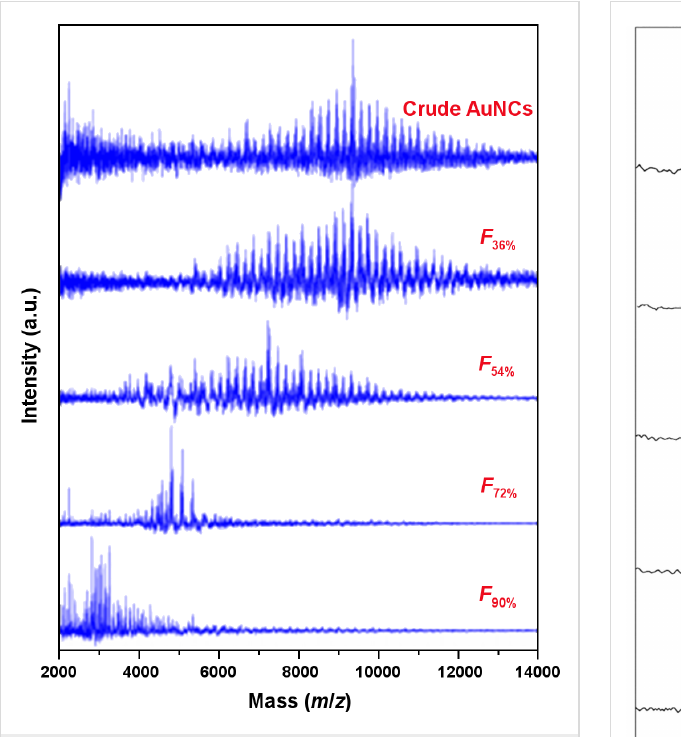
Figure 6: MALDI-TOF mass spectra of the crude AuNC product and SSSP fractions after baseline subtraction.